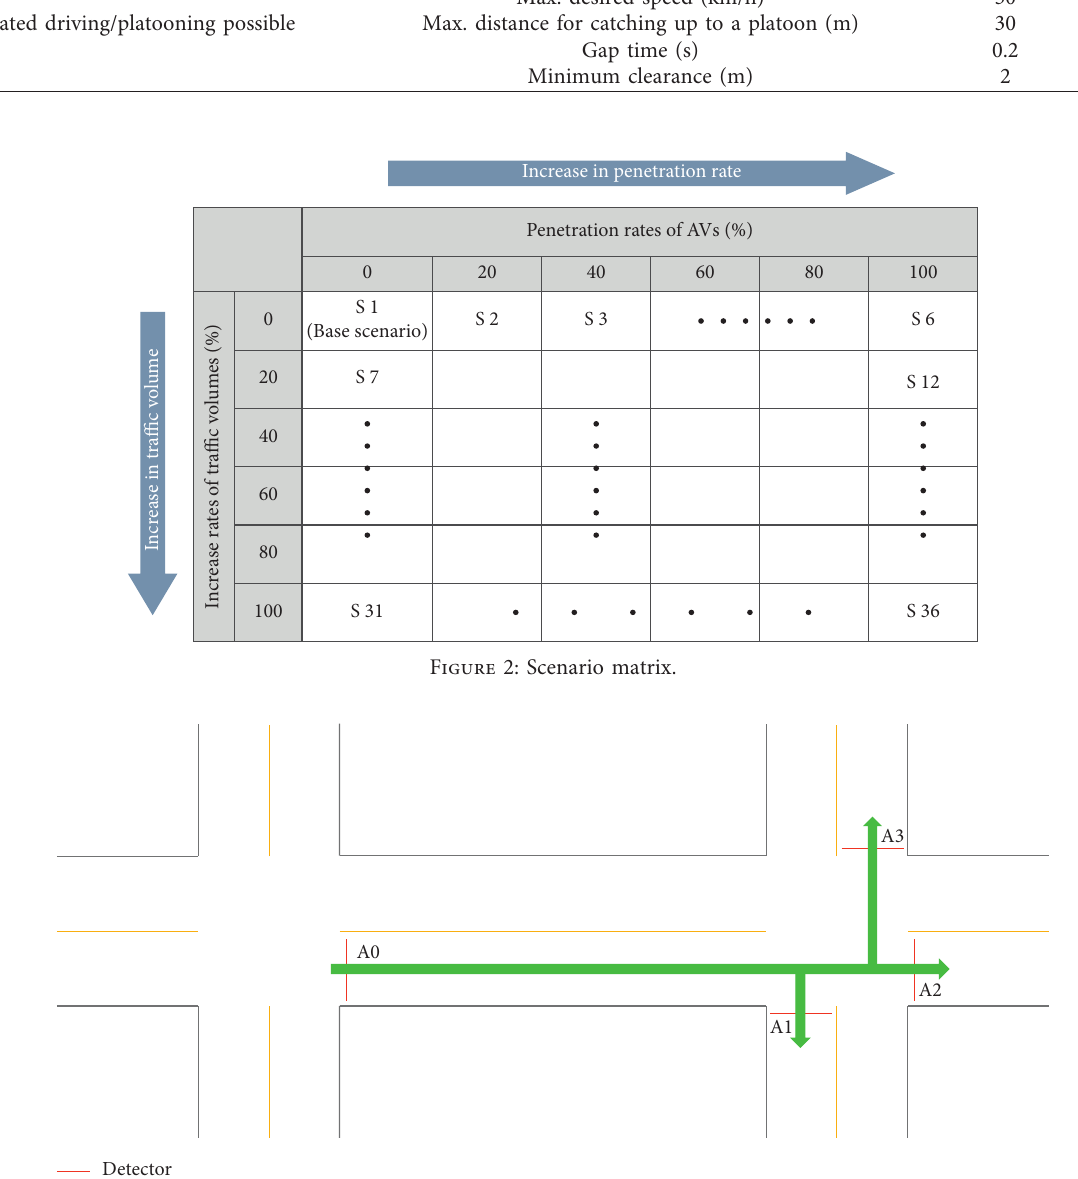
Figure 3: Location of detectors.